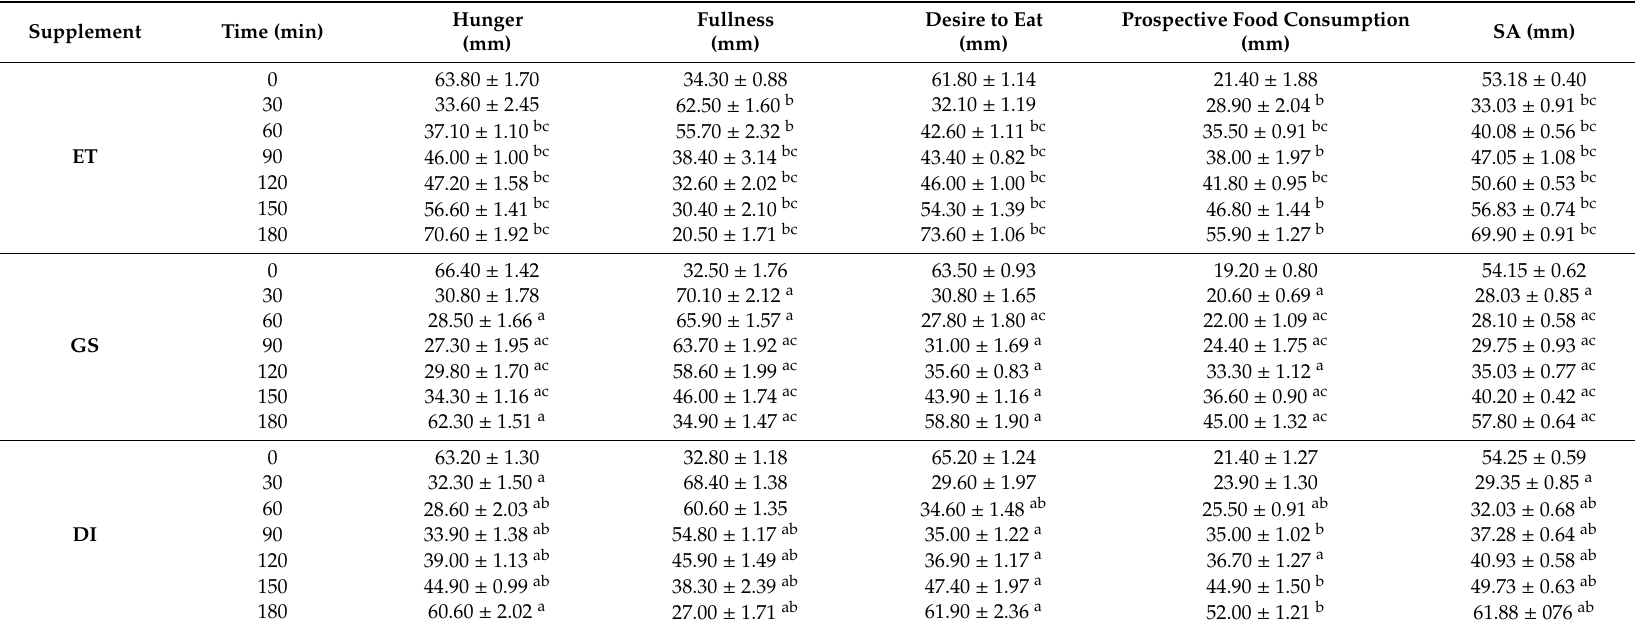
Table 5. Subjective appetite measurements according to each